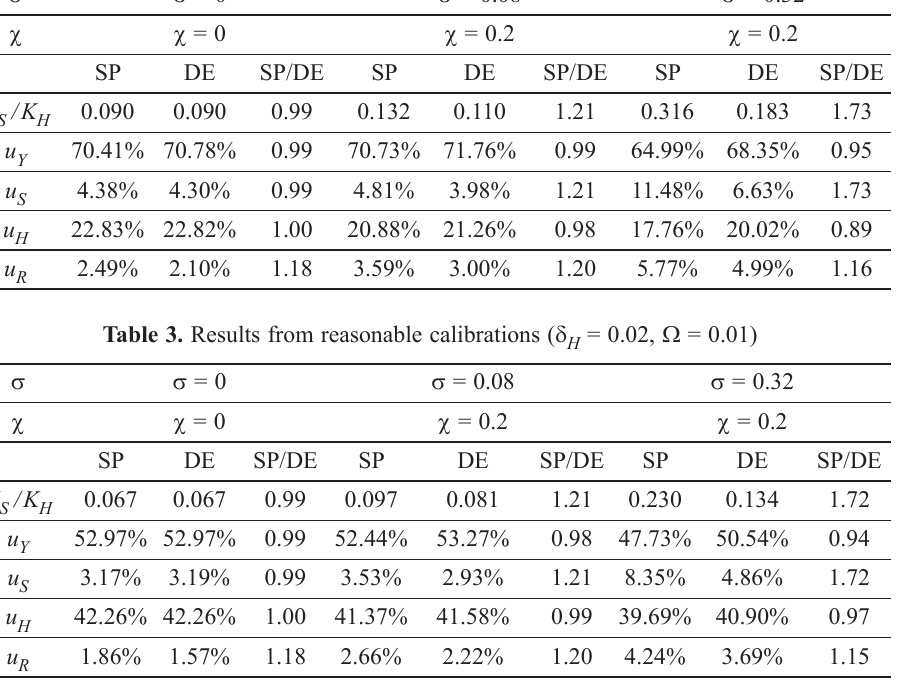
Table 4. Results from reasonable calibrations ( δ